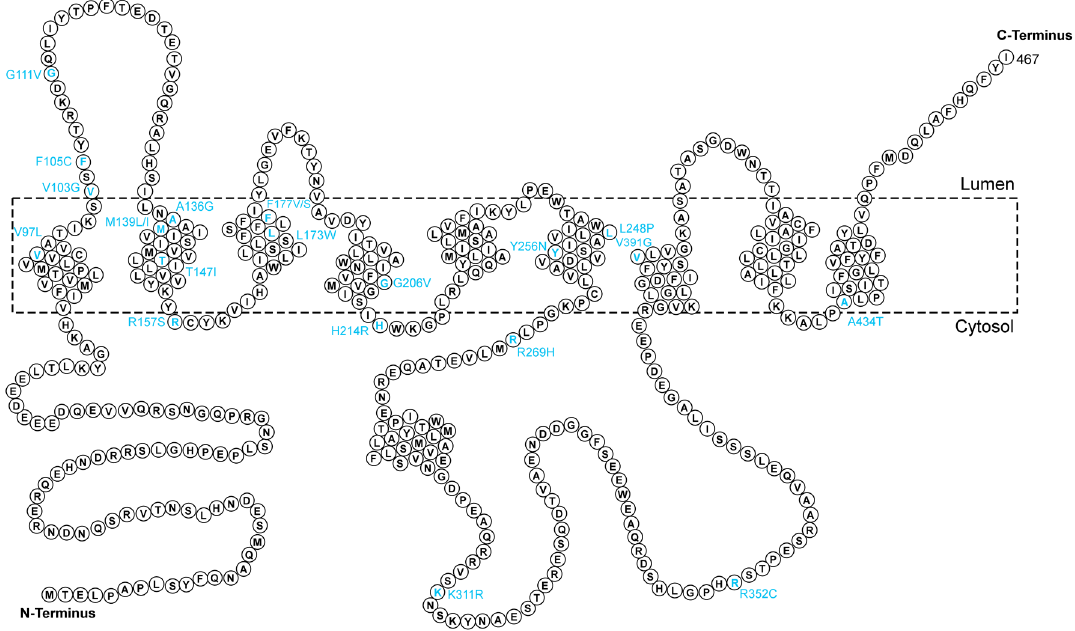
Figure 2. Amino acid sequence of presenilin 1 (PSEN1). The reported distribution of mutations in the Chinese population is labeled in cyan at the corresponding